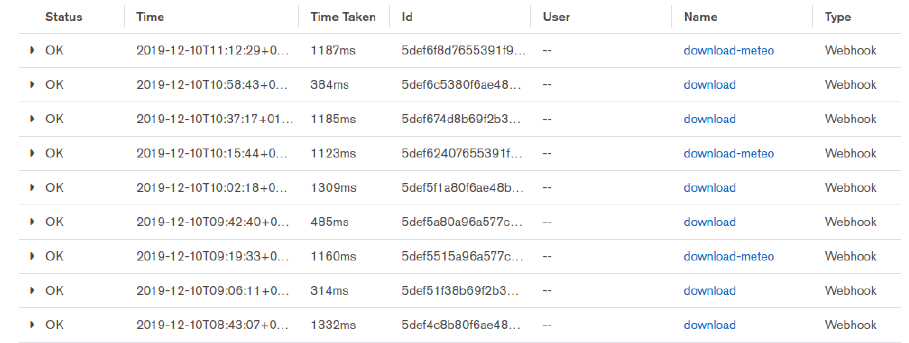
Figure 6. An example of the log file available on the Atlas Web interface. The third column shows the execution time of the function indicated in column